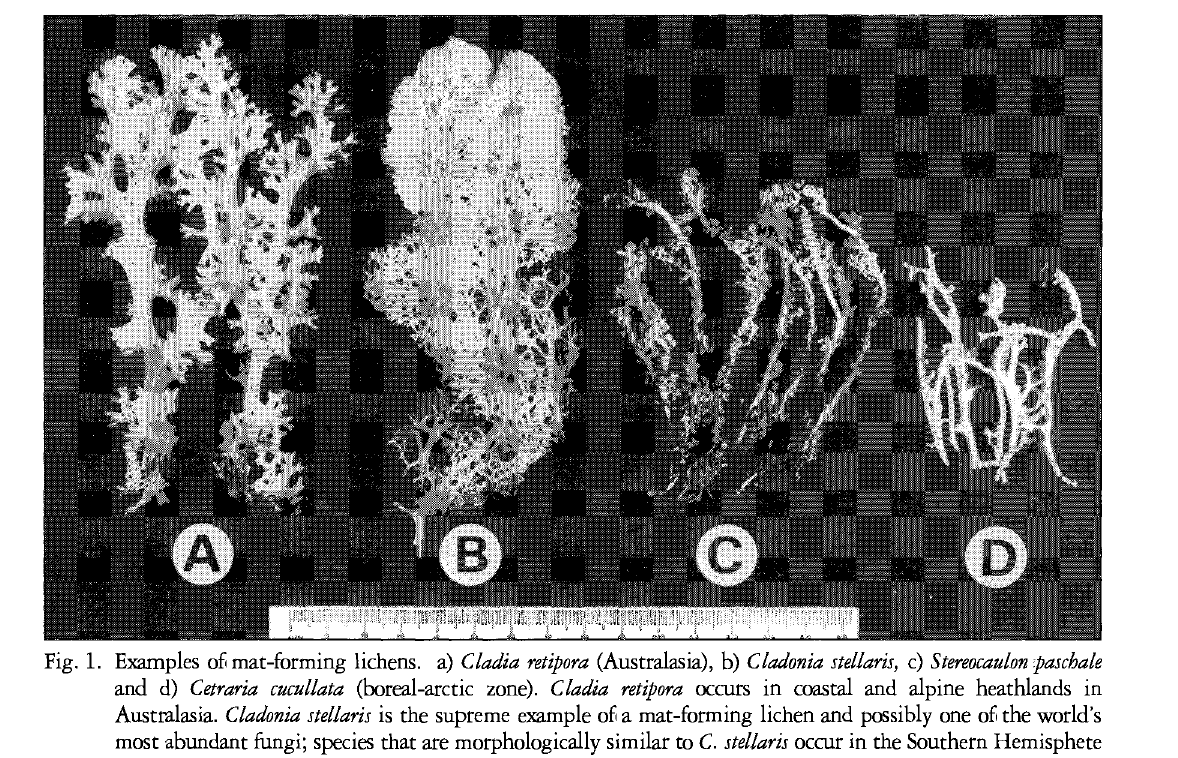
Fig. 1. Examples of mat-forming lichens, a) Cladia retipora (Australasia), b) Cladonia stellaris, c) Stereocaulon paschale and d) Cetraria cucullata (boreal-arctic zone). Cladia retipora occurs in coastal and alpine heathlands in Australasia. Cladonia stellaris is the supreme example of a mat-forming lichen and possibly one of the world's most abundant fungi; species that are morphologically similar to C. stellaris occur in the Southern Hemisphete e.g. C. pycnoclada, C. leptoclada and C. confusa, which locally form extensive ground